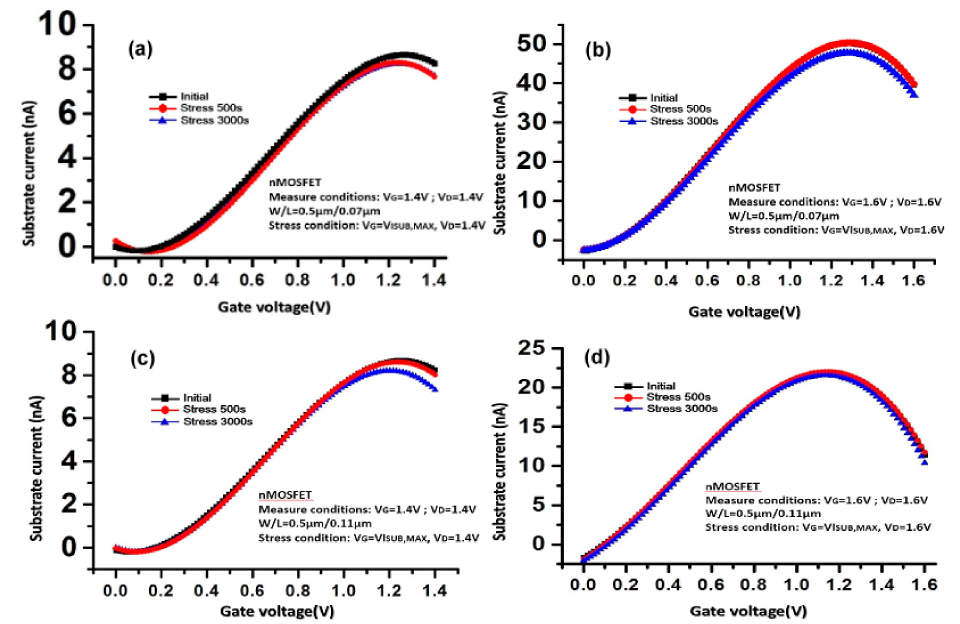
Figure 7. In drain-avalanche-hot carrier (DAHC) test mode, the I SUB at: ( a ) W / L = 0.5 / 0.07 µ m / µ m, stressed at V GS at I SUB_max plus V DS = 1.4 V, ( b ) W / L = 0.5 / 0.07 µ m / µ m, stressed at V GS at I SUB_max and V DS = 1.6 V, ( c ) W / L = 0.5 / 0.11 µ m / µ m, stressed at V GS at I SUB_max and V DS = 1.4 V, and ( d ) W / L = 0.5 / 0.11 µ m / µ m, stressed at V GS at I SUB_max and V DS = 1.6 V.